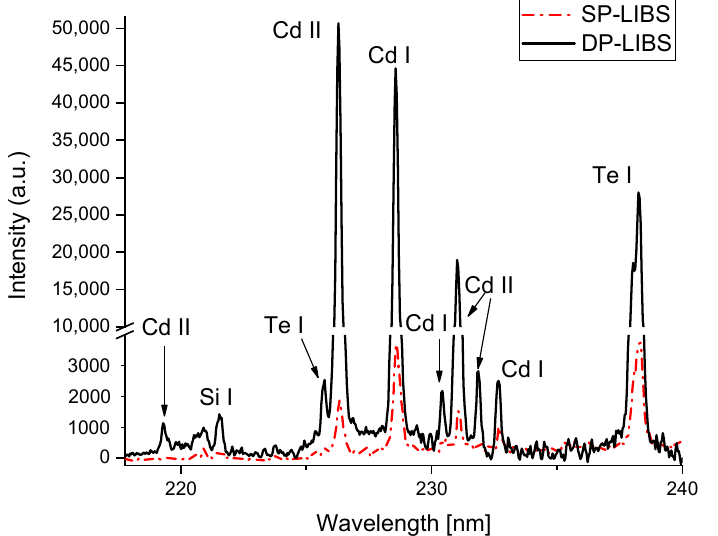
Figure 4. Comparison of time-integrated spectra obtained for SP-LIBS and DP-LIBS obtained from a single shot over a thin film target.